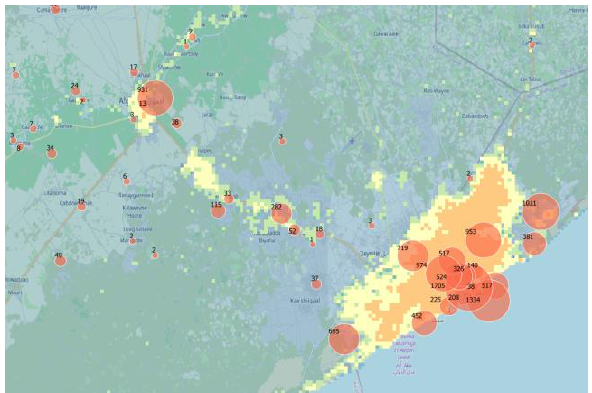
Figure 8. GHS-POP 2015 correlated with conflict locations clusters in Mogadishu.